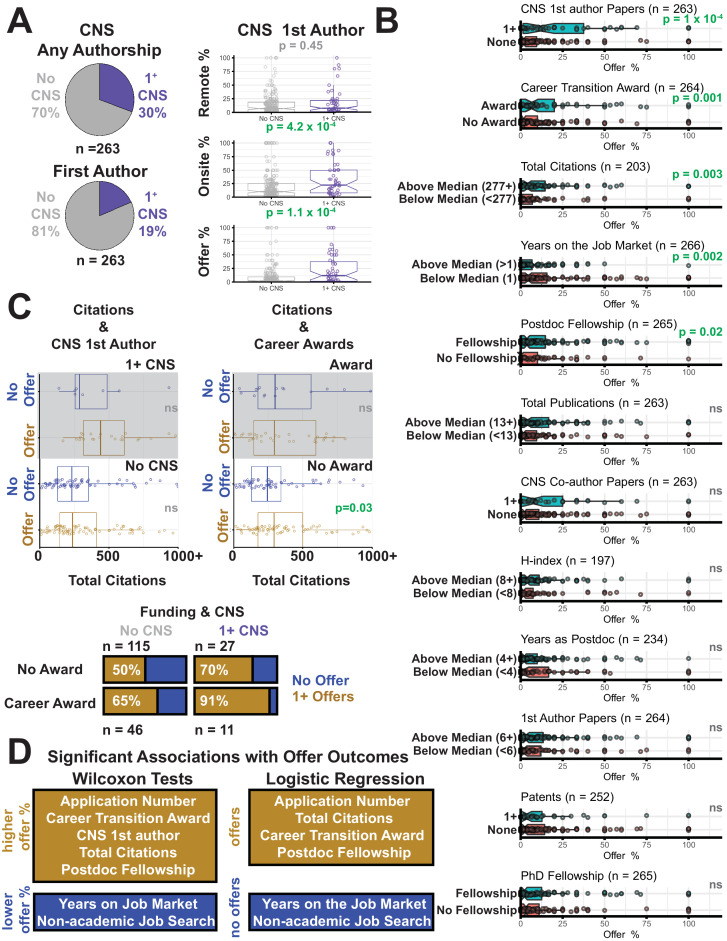
Life-science specific analysis of applicant survey outcomes.We performed identical analysis as in Figure 5 but restricted to applicants (n = 269) who described their field as life-science related (as defined in Figure 2).